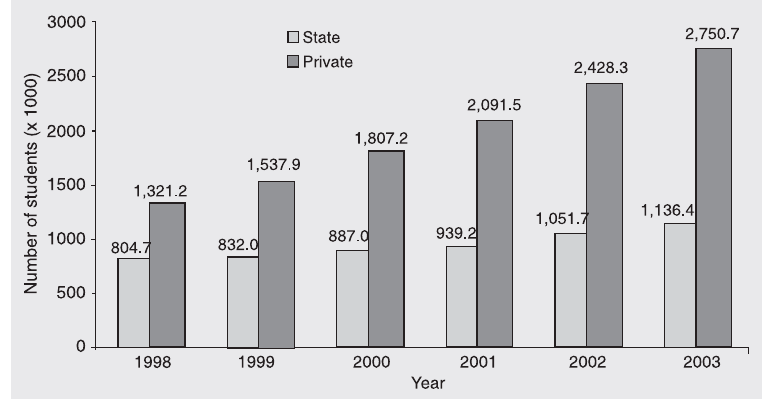
Figure 11. Number of undergraduate students enrolled in state and private universities between 1998 and 2003 (original data source: Instituto National de Estu- dos e Pesquisas Educacionais Anísio Teixeira, INEP,